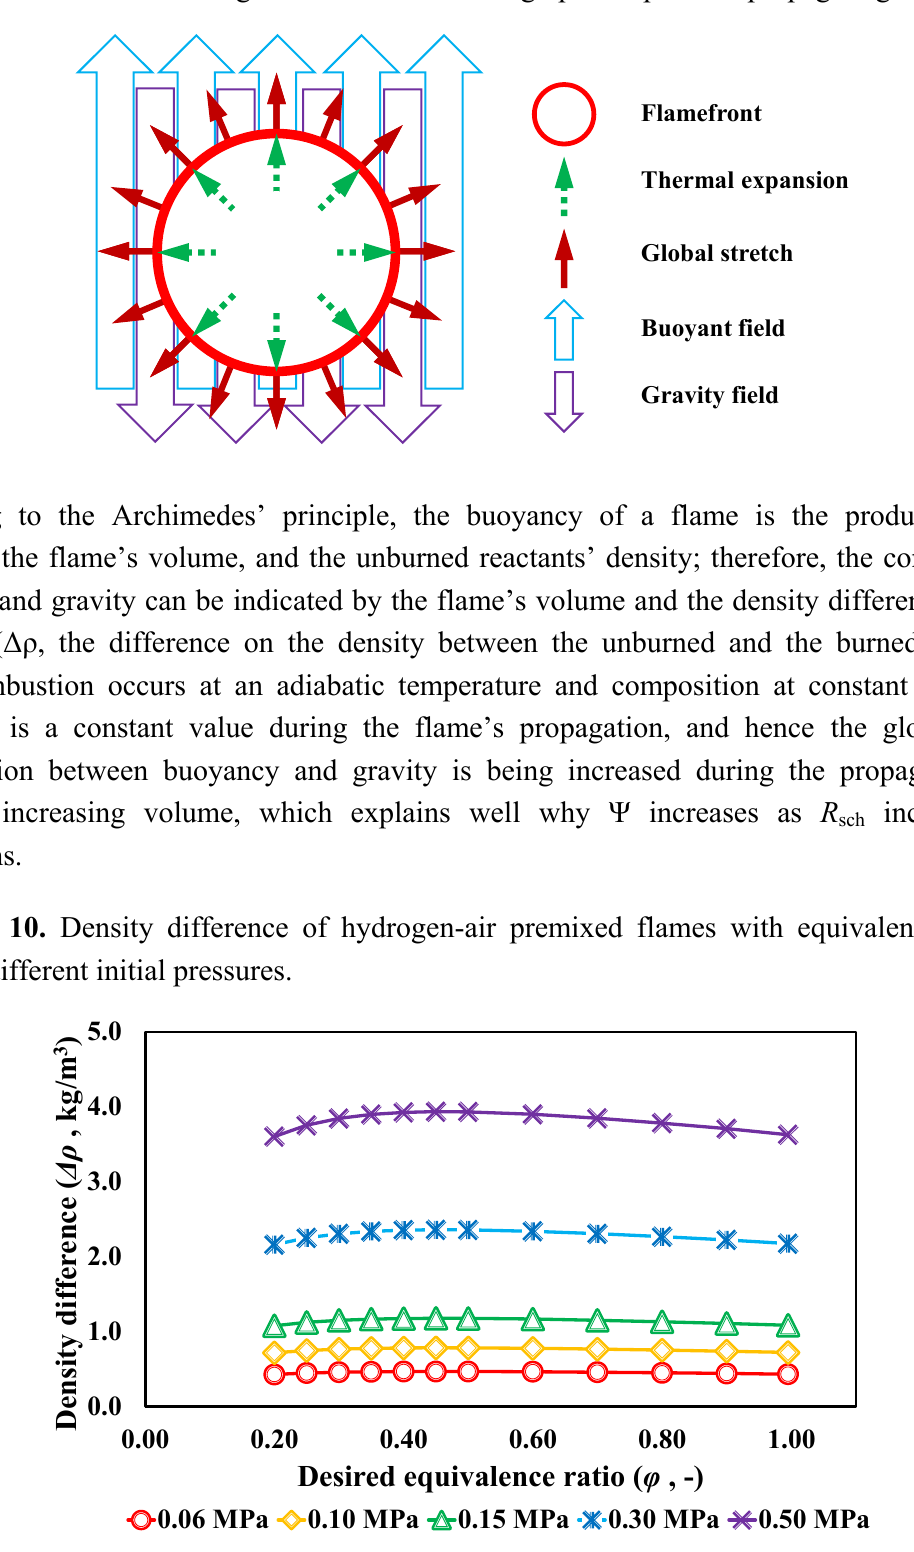
Figure 9. Schematic diagram of the forces acting upon a spherical propagating flame.